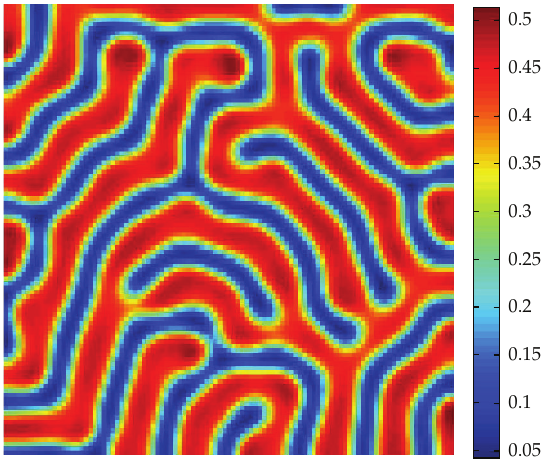
𝐻 in model (8) for 𝑚 = 0.85 at 𝑡 = 1000